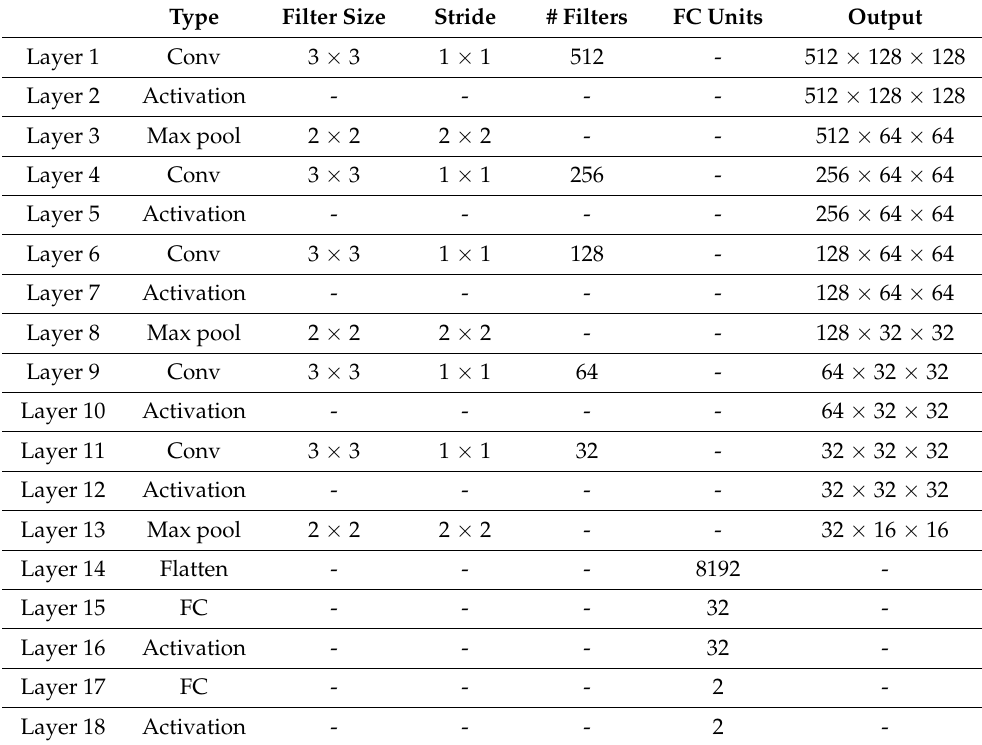
Table 3. The main architecture of